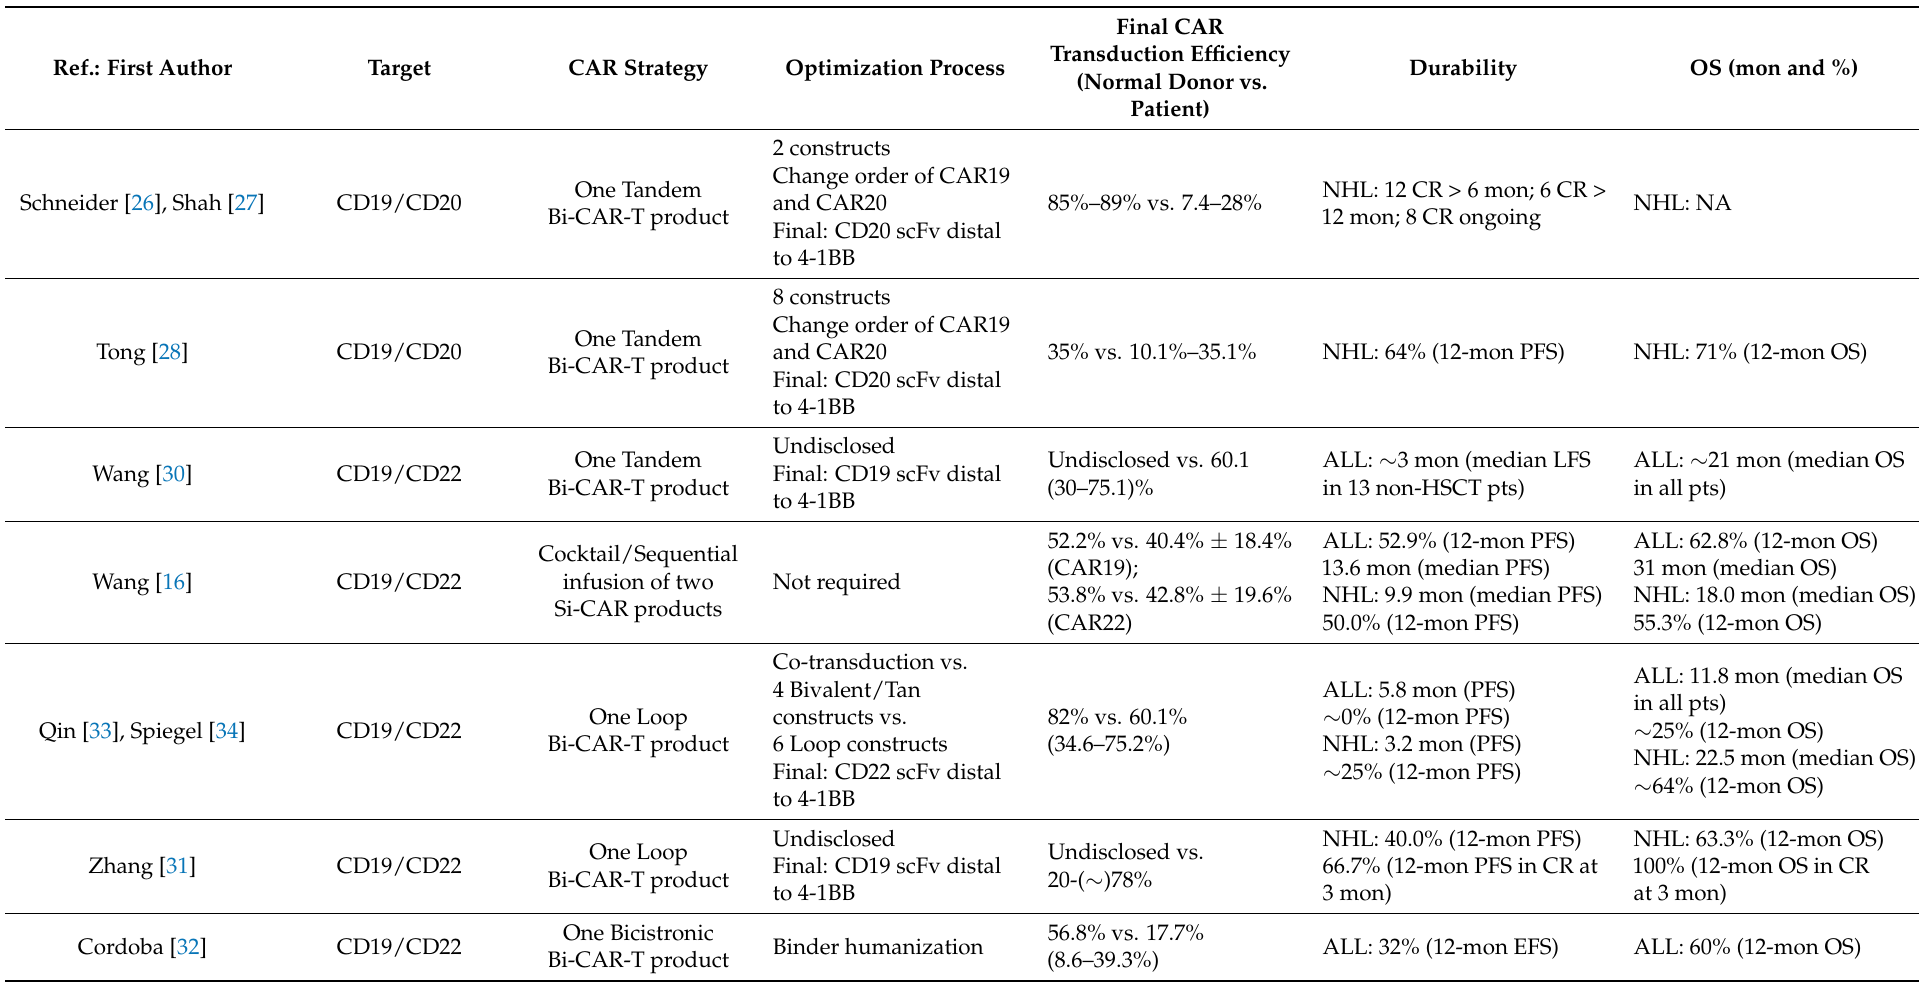
Table 8. Comparison of optimization process, transduction efficiencies, DOR, and OS among different dual-targeting CAR T-cell therapies ( n > 10; ALL and